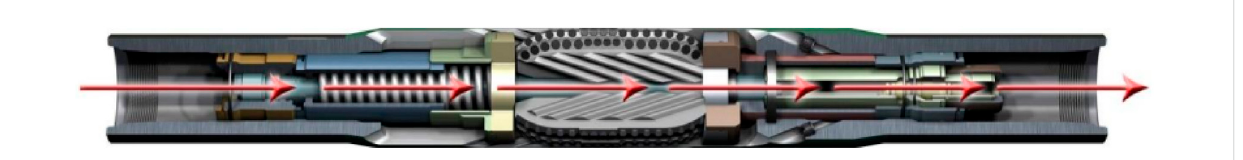
FIGURE 1 Deactivation state of the tool.